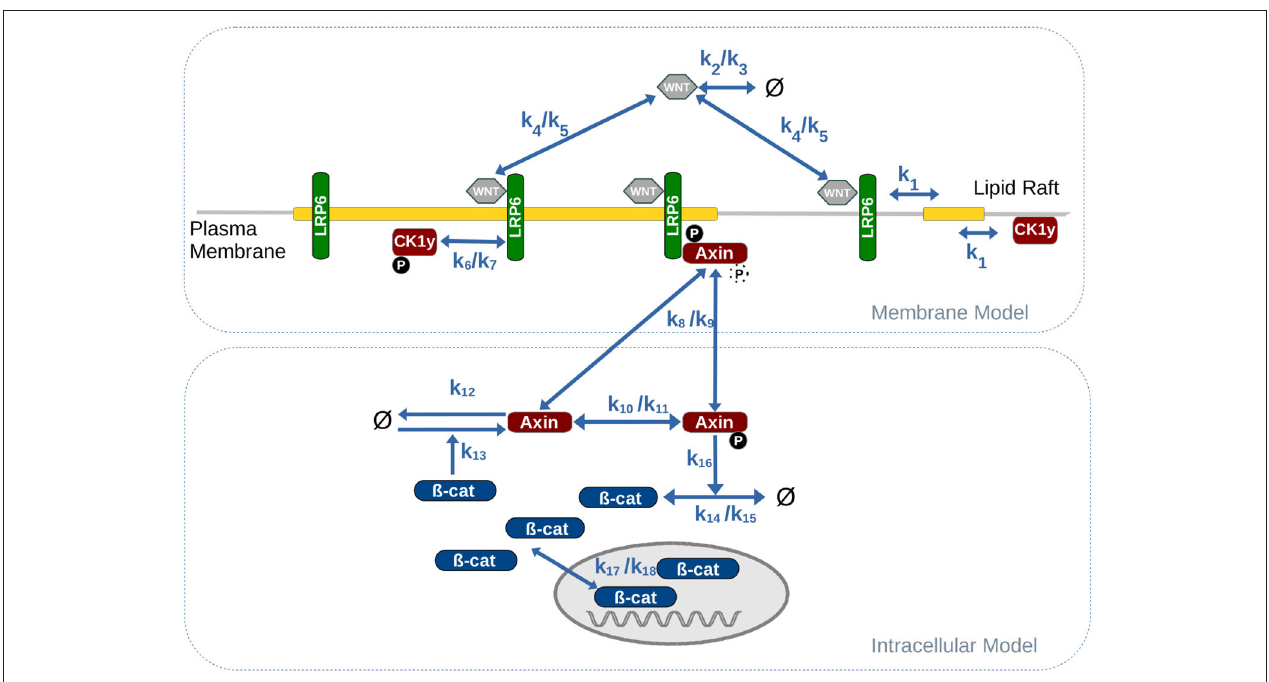
FIGURE 2 | Combined model of intracellular WNT signaling and membrane dynamics. Parameter values for the reaction rates are listed in Table 1 .